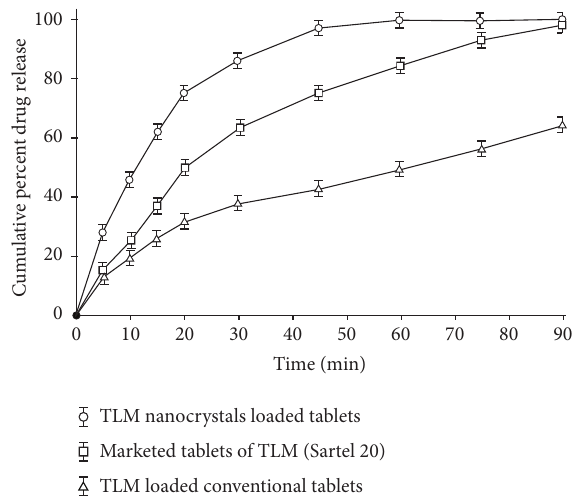
Figure2:Comparisonof invitro drugreleaseprofilesofTelmisartan (TLM) loaded nanosuspension, marketed formulation, and conven- tional